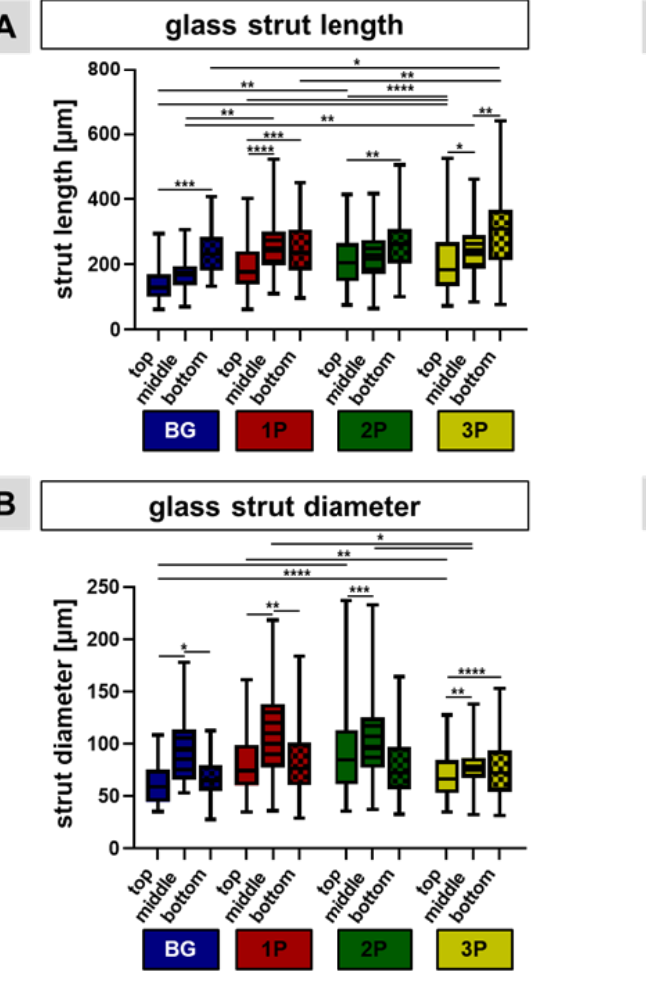
Figure 3. Calculation of scaffold parameters. The glass strut length ( A ), the glass strut diameter ( B ) and the pore perimeter ( C ) were measured in the top, middle and bottom regions of the BG (blue), the 1P (red), the 2P (green) and the 3P (yellow) scaffolds. 1P = single, 2P = twofold, 3P = threefold PLGA infiltrations. Four technical and three biological replicates were included and significant differences were calculated after ordinary two-way ANOVA with multiple comparison (*) for p < 0.05; (**) for p < 0.01; (***) for p < 0.001 and with (****) for p < 0.0001. The porosity ( D ) was measured with three different scaffolds from each scaffold variant (BG, 1P, 2P, 3P).